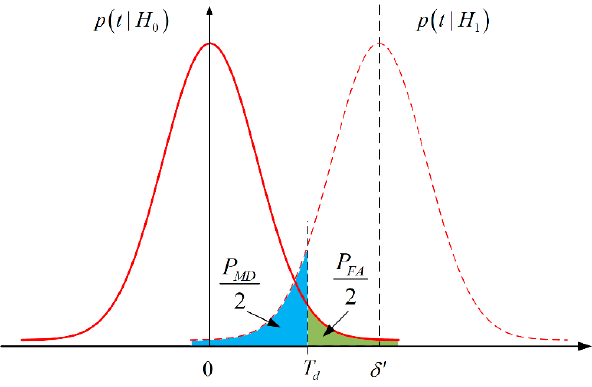
Figure 1. Probability density functions of hypotheses test for fault detection.